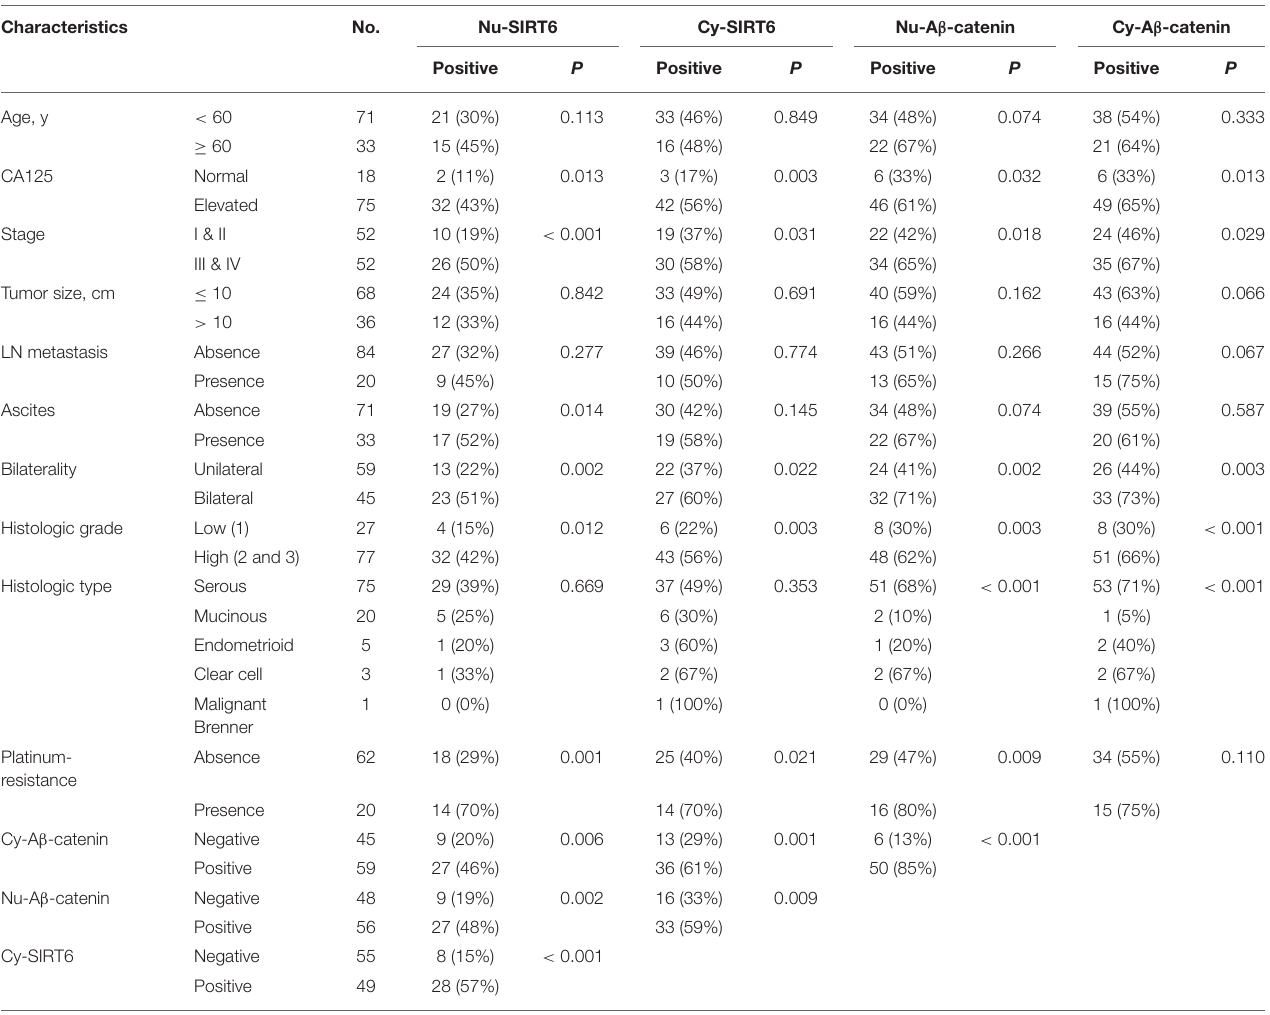
TABLE 2 | Clinicopathological variables and expression of SIRT6 and active β -catenin in 104 ovarian carcinomas.